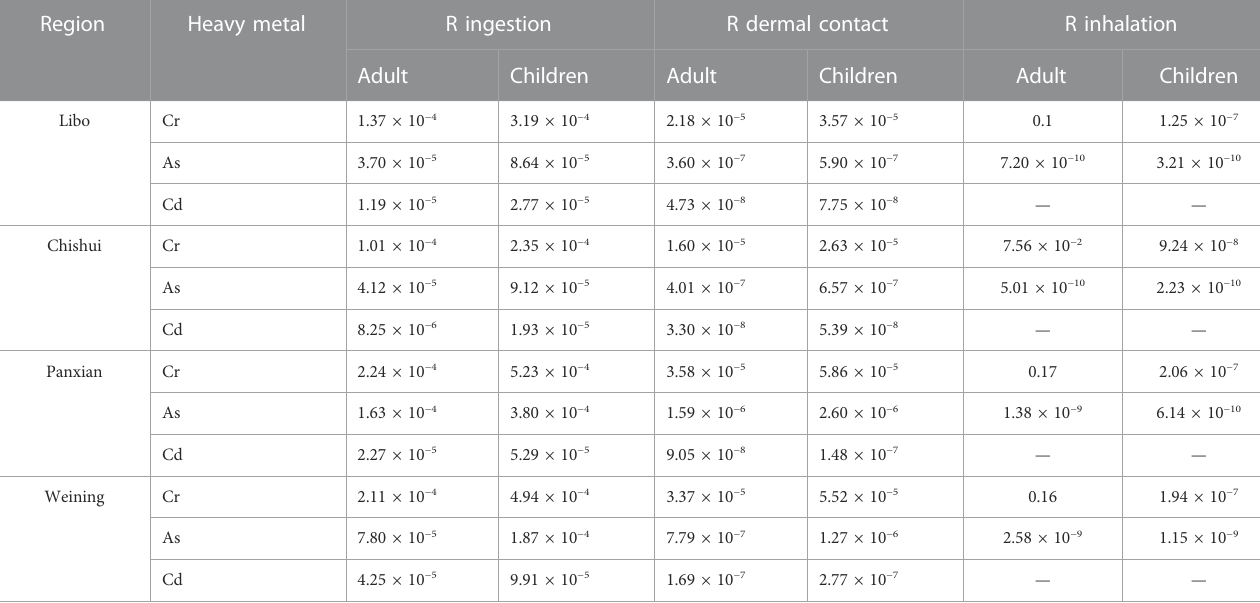
TABLE 3 Carcinogenic health risk index.